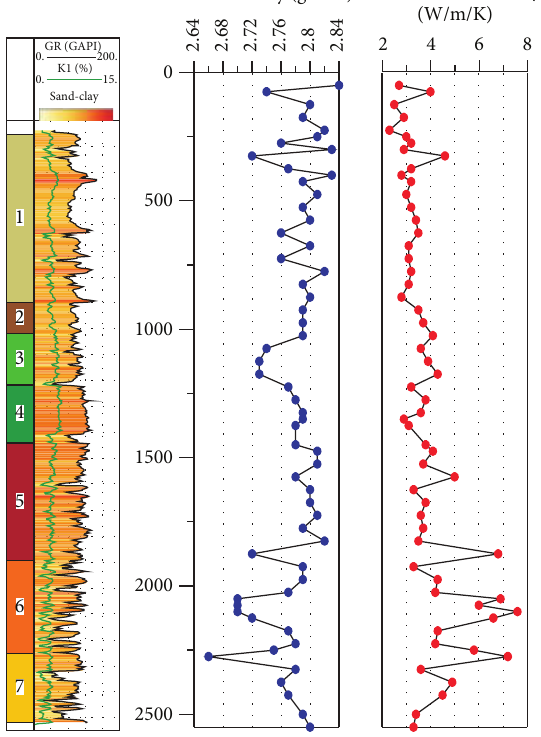
Upper Devonian series between 1016 m and 1440 m depth.